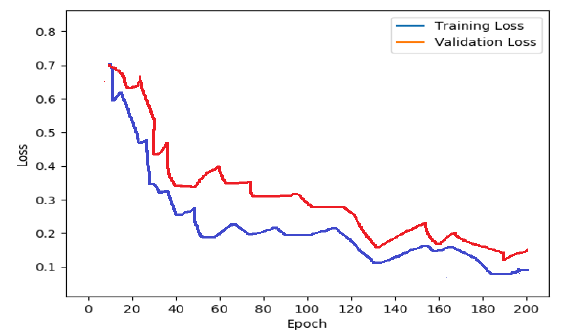
Figure 15. Training and Validation loss